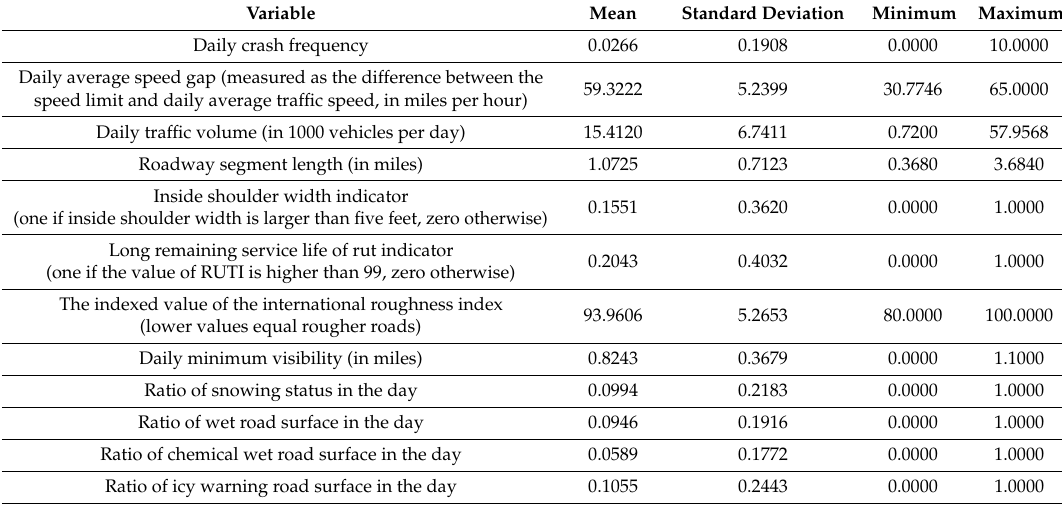
Table 1. Summary statistics of the data for